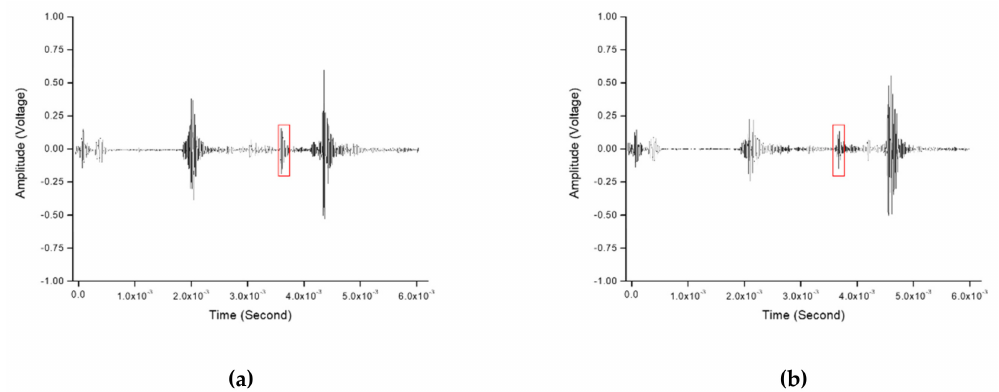
Figure 19. Ultrasonic signals of a dissimilar-metal weldment specimen with notch using ( a ) a 45 ◦ oblique incidence and ( b ) 60 ◦ oblique incidence through stainless